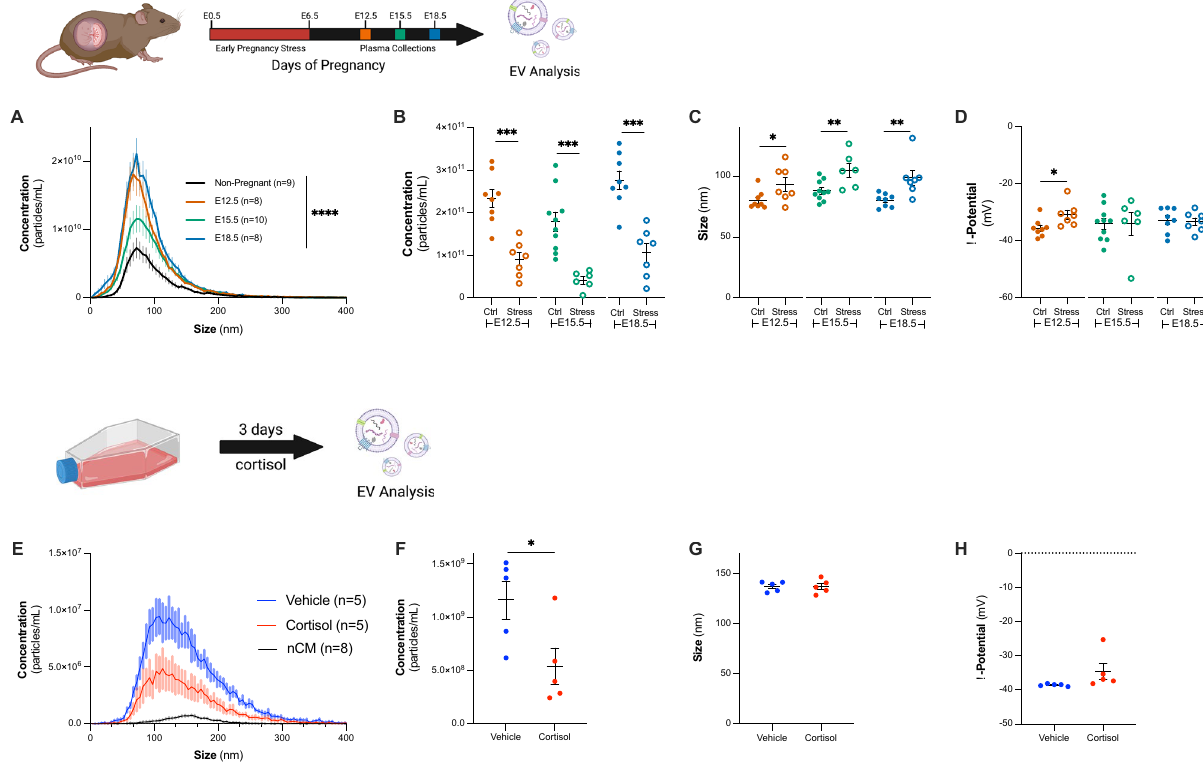
Figure 2. Robust increase in circulating EV concentration during pregnancy is significantly decreased by stress in vivo, and glucocorticoids in vitro. ( A ) There was a significant effect of pregnancy on the concentration of EVs in vivo (one-way ANOVA, main effect of treatment, F 3,31 = 12.46, p < 0.0001). Non-pregnant dams shown in black (n = 9), E12.5 dams in orange (n = 8), E15.5 dams in green (n = 10), and E18.5 dams in blue (n = 8). ( B – D ) We investigated changes to circulating EVs as a result of maternal stress (open circles). ( B ) E12.5 stressed dams (n = 7, open orange circles) had a concentration of 9.1 × 10 10 ± 1.6 × 10 10 particles/mL plasma, at E15.5 (n = 6, open green circles) 4.2 × 10 10 ± 8.6 × 10 9 particles/mL, and at E18.5 (n = 7, open blue circles) 1.1 × 10 11 ± 2.2 × 10 10 particles/mL. Stress produced a significant decrease in circulating EVs (E12.5, two-tailed t -test, t 13 = 5.285, p = 0.0001; E15.5, two-tailed t -test, t 14 = 4.502, p = 0.0005; E18.5, two-tailed t -test, t 13 = 5.424, p = 0.0001) and ( C ) a significant increase in EV size. EVs from E12.5 control dams were 80.38 ± 2.7 nm, whereas EVs from stressed dams were 93.3 ± 5.5 nm (two-tailed t -test, t 13 = 2.205, p = 0.046). EVs from E15.5 control dams were 88.0 ± 2.6 nm, whereas EVs from stressed dams were 104.8 ± 5.8 nm (two-tailed t -test, t 14 = 3.028, p = 0.009). EVs from E18.5 control dams were 80.1 ± 1.9 nm, and EVs from E18.5 stressed dams were 98.7 ± 5.9 nm (two-tailed t -test, t 13 = 3.143, p = 0.0078). ( D ) E12.5 EVs from control dams were − 35.5 ± 1.1 mV, and E12.5 EVs from stressed dams were − 30.8 ± 1.6 mV (two-tailed t -test, t 13 = 2.503, p = 0.0264). E15.5 EVs from control dams were − 34.0 ± 1.9 mV, and E15.5 EVs from stressed dams were − 34.1 ± 1.6 mV (two-tailed t -test, t 14 = 0.03167, p = 0.9752). E18.5 EVs from control dams were − 32.7 ± 1.6 mV, and E18.5 EVs from stressed dams were − 33.3 ± 1.3 mV (two-tailed t -test, t 13 = 0.2837, p = 0.7811). ( E ) Cortisol treatment (red, n = 5) significantly decreased concentration of EVs in media of BeWo-b30 cells to 5.39 × 10 8 ± 1.71 × 10 8 particles/mL, compared to vehicle treated (blue, n = 5) which had a concentration of from 1.16 × 10 9 ± 1.77 × 10 8 particles/ mL. Non-conditioned media (black, n = 8) had a concentration of 6.54 × 10 7 ± 4.89 × 10 6 particles/mL. ( F ) The concentration of EVs secreted into the media was significantly decreased following cortisol treatment (two-tailed t -test, t 8 = 2.532, p = 0.0351). Cortisol exposure did not alter the ( G ) size (vehicle = 137.0 ± 3.1 nm v. cortisol = 137.1 ± 2.2 nm, two-tailed t -test, t 8 = 0.0275, p = 0.9787) or ( H ) ζ-potential of EVs (vehicle = -34.6 ± 2.4 mV v. cortisol = − 38.5 ± 0.15 mV, two-tailed t -test, t 8 = 1.652, p = (E12.5, 2.3 × 10 11 ± 2.1 × 10 10 particles/mL, p = 0.0007, n = 8; E15.5, 1.8 × 10 11 ± 2.3 × 10 10 particles/mL, p = 0.0489, n = 10; E18.5, 2.8 × 10 11 ± 2.2 × 10 10 particles/mL, p < 0.0001, n = 8). As we previously identified changes to O-GlcNAcylation of placental ANXA1 as a result of maternal stress during pregnancy 6 , we next evaluated changes to circulating EVs following maternal stress (Fig. 2B–D). At E12.5 stressed dams (n = 7) had a concentration of 9.1 × 10 10 ± 1.6 × 10 10 particles/mL plasma, at E15.5 (n = 6) 4.2 × 10 10 ± 8.6 × 10 9 particles/mL, and at E18.5 (n = 7) 1.1 × 10 11 ± 2.2 × 10 10 particles/mL (Fig. 2B). Across all three gestational days, there was a significant decrease in concentration of EVs associated with stress (Fig. 2B, E12.5, two-tailed t -test, t 13 = 5.285, p = 0.0001; E15.5, two-tailed t -test, t 14 = 4.502, p = 0.0005; E18.5, two- tailed t -test, t 13 = 5.424, p = 0.0001). We also compared the size and ζ-potential of particles in each group. We observed an increase in particle size associated with stress (Fig. 2C). At E12.5, EVs from control dams were